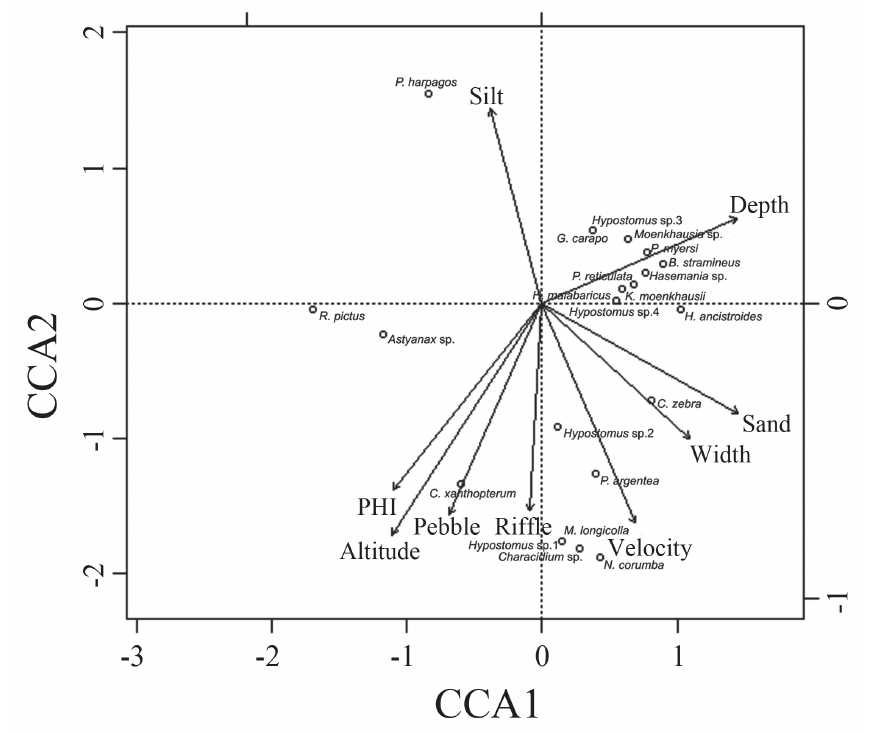
Fig. 4. Biplot of the two first axis resulting from Canonical Correspondence Analysis (CCA) showing fish species scores (open circles) and significant environmental variables (arrows) in streams of the APA Gama and Cabeça de